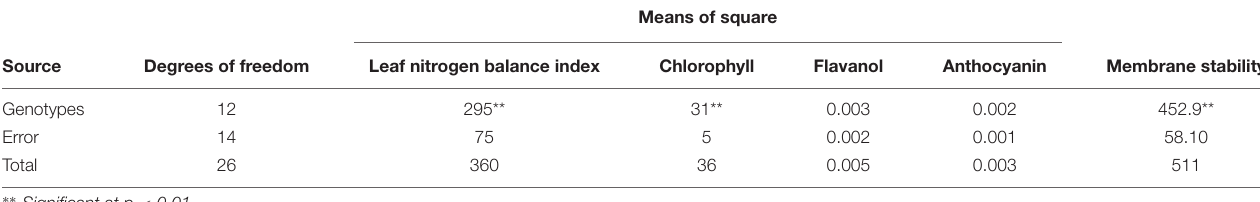
TABLE 5 | Analysis of variance of fluorescence parameters of 13 tested urdbean genotypes.